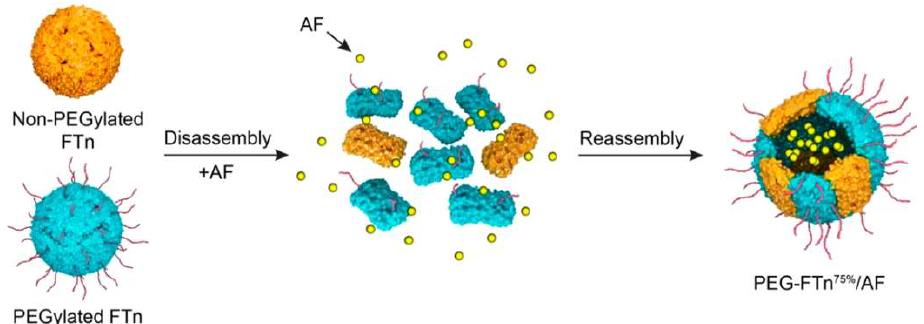
Figure 4. Structure and loading procedure for AF-loaded hybrid PEGylated FN. Hybrid FNs can be developed by utilizing the pH disassembly/reassembly methodology, starting from two different FNs (in this case, a PEGylated FN and non-PEGylated FN). In addition, prior to the reassembly phase, anticancer drugs can be added, resulting in their inclusion inside the FN nanostructure after reassembly. Adapted from [39], American Chemical Society, 2019.